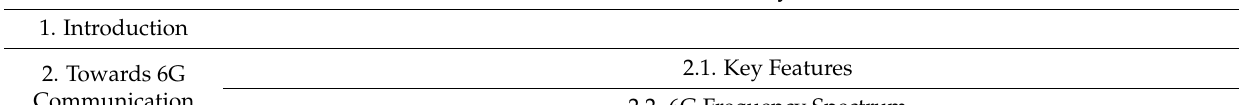
Figure 2. Diagram of integrated 5G/satellite 6G communication system vision. Table 1. The structure of the paper. Towards 6G Communication: 5G Antennas, Arrays, and Wearable